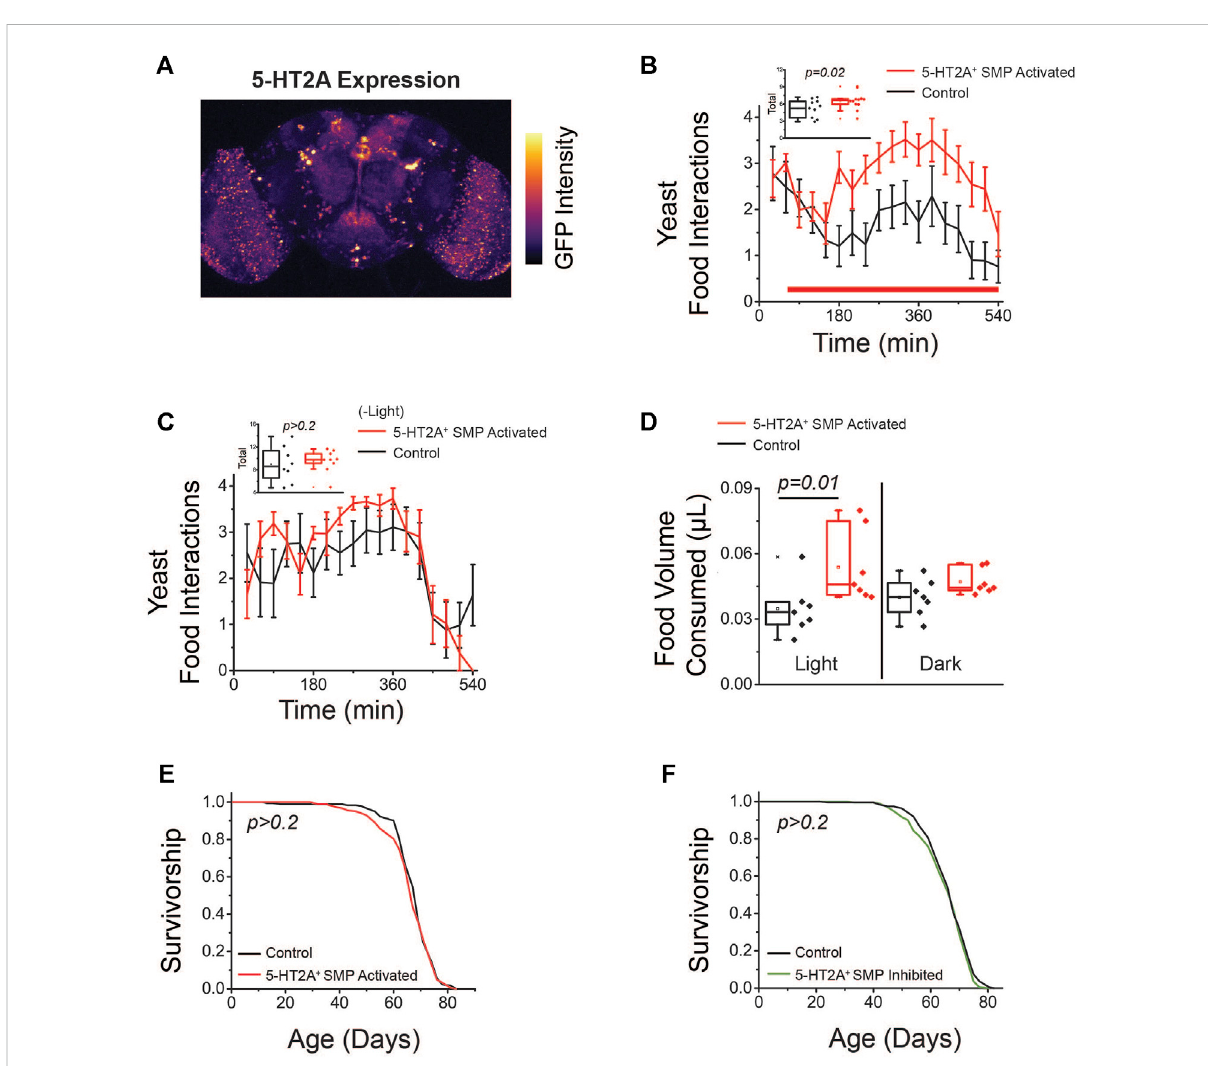
FIGURE 5 Activation of 5-HT2A + SMP neurons promotes protein feeding behaviors. (A) GFP labeling of neurons driven by 5-HT2A-GAL4 in the brain (image is a max projection). (B) Activation of 5-HT2A + SMP neurons (red bar indicates red light activation period) promotes acute interaction with a protein solution. Inset: Quanti fi cation of total interactions during the light period ( n = 11 and 12, one-sided t -test p = 0.02). (C) Flies expressing CsChrimson in 5-HT2A + SMP neurons do not show differences in interactions with a protein solution in the absence of red light activation ( n = 8 and 9, two-sided t -test p = 0.68). (D) Activation of 5-HT2A + SMP neurons promotes consumption of high protein solid food ( n = 7 where each replicate consists of 10 fl ies, one-sided t -test p = 0.01) and fl ies expressing CsChrimson in 5-HT2A + SMP neurons do not show differences in solid food consumption relative to controls in the absence of red light activation ( n = 7 where each replicate is comprised of 10 fl ies, one-sided t -test p = 0.09). (E) Activation( n =182and185,log-rankanalysis p =0.5)and (F) inhibition( n =186and191,log-rankanalysis p =0.2)of 5-HT2A +